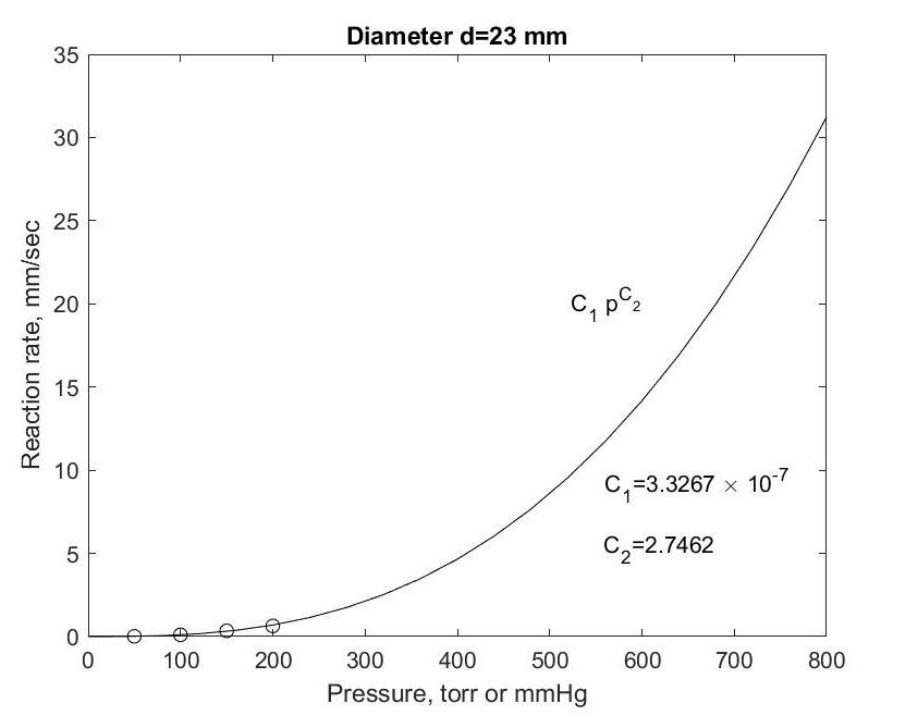
Figure 3. Methane reaction rate as a function of